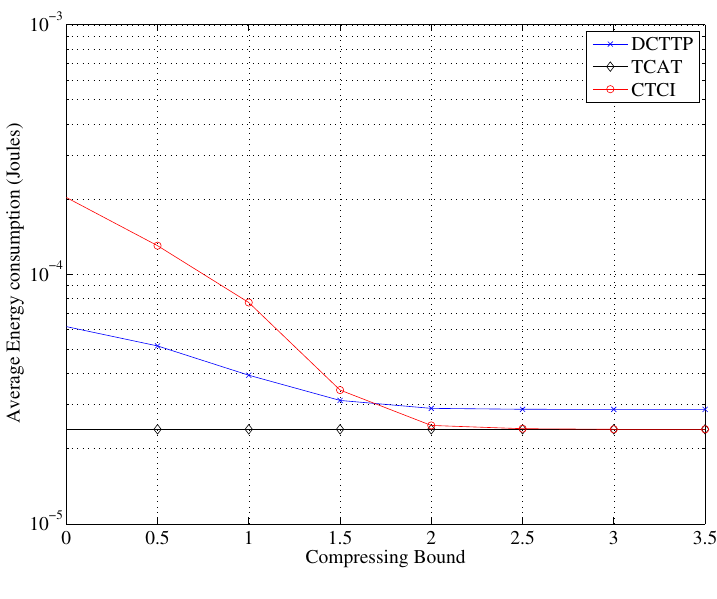
Figure 27. Impact of the compressing bound on the average energy